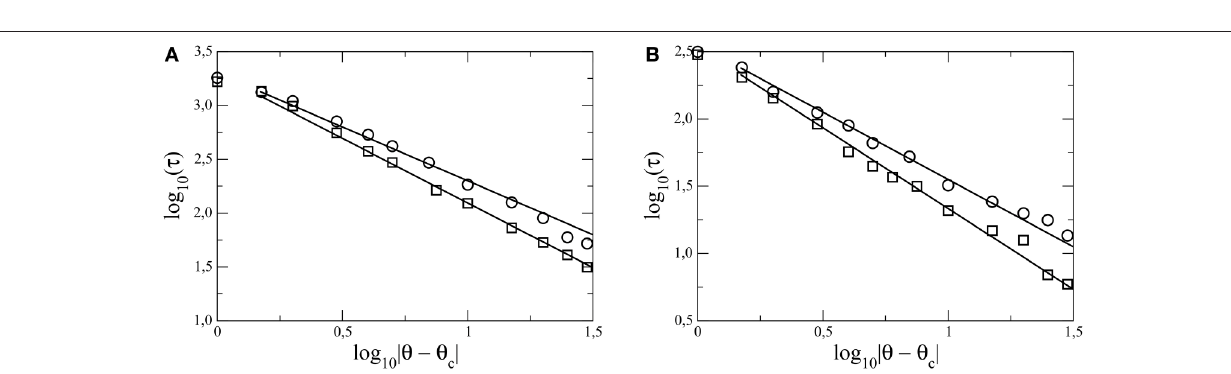
channels forever and the system stays in the same